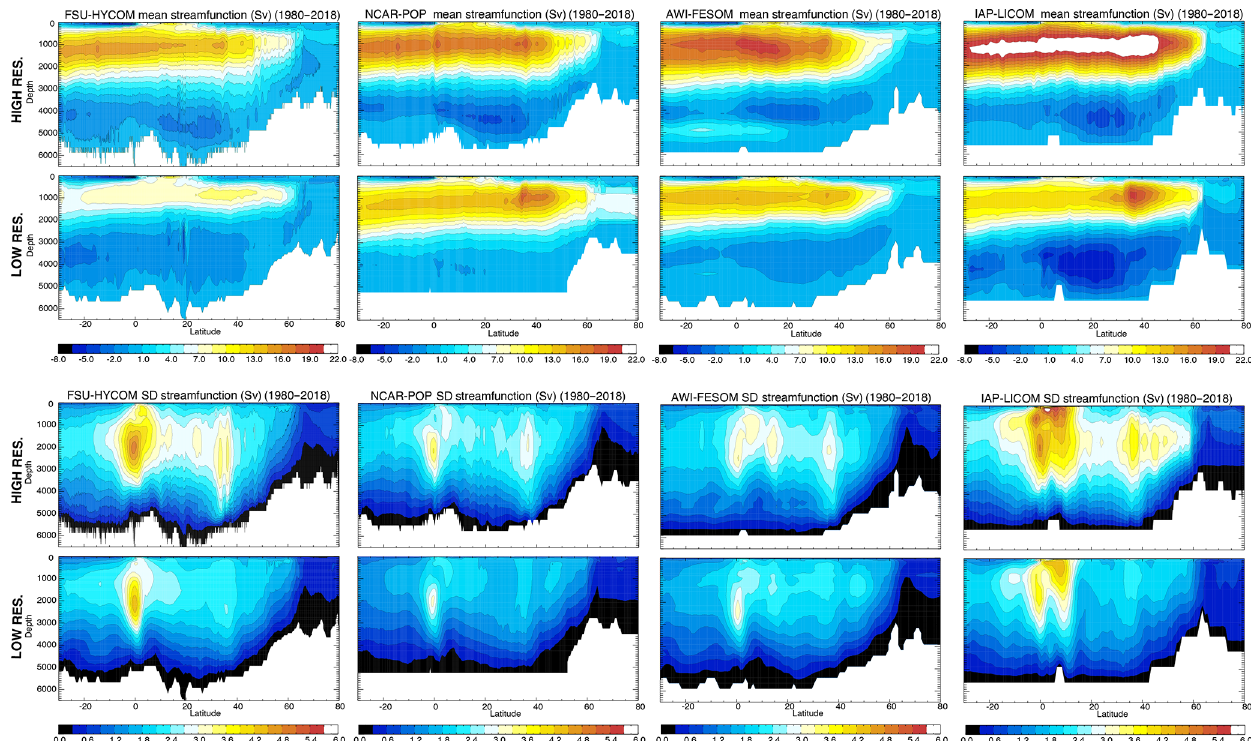
Figure 26. Top panels: modeled time mean (1980–2018) Atlantic meridional overturning streamfunction ψ z (yz) in the four models (low and high resolution). Lower panels: modeled standard deviation (1980–2018) of the Atlantic overturning streamfunction ψ z (yz) derived from monthly mean fields.